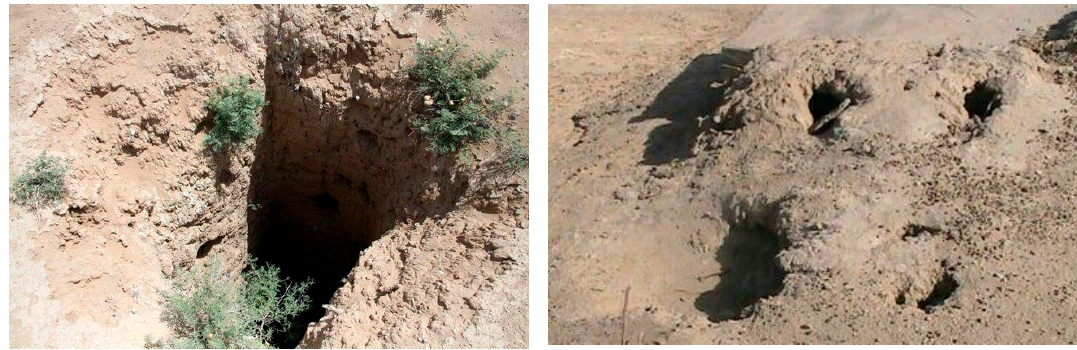
Figure 2. Pictures of piping erosion in Zarandieh watershed.